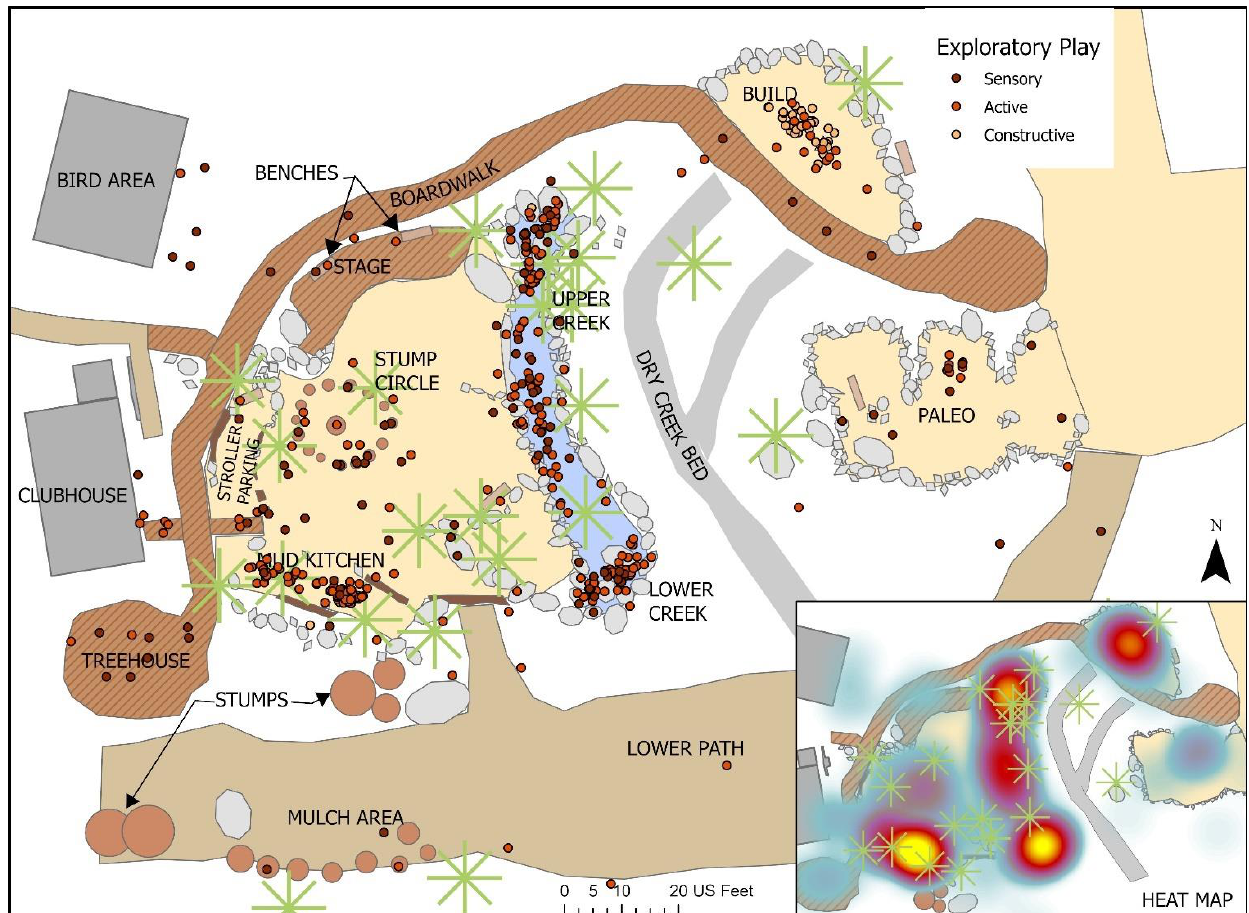
Figure 15. Behavior map of all Exploratory Play